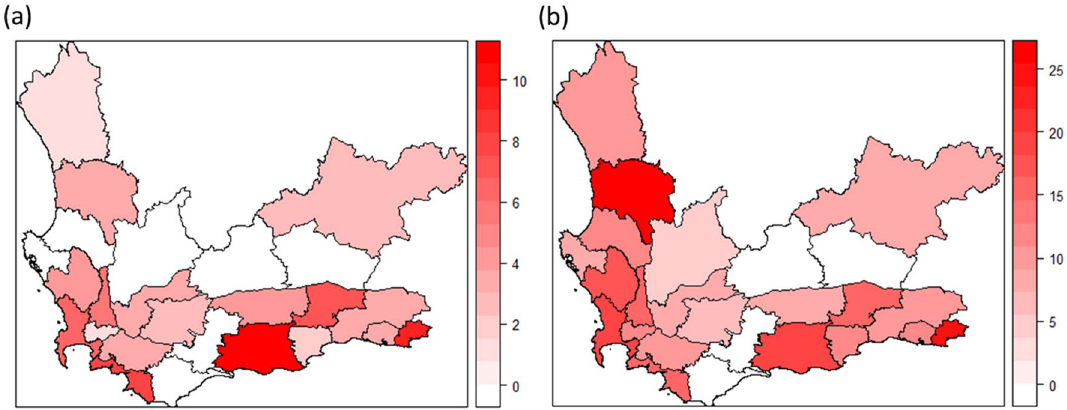
Figure 1. ( a ) Percentage XDR-TB in the Western Cape aggregated by subdistrict ( b ) pre-XDR/XDR-TB in the Western Cape aggregated by subdistrict. Figure created in R statistical software version 3.4.1 23 . XDR-TB extensively drug-resistant